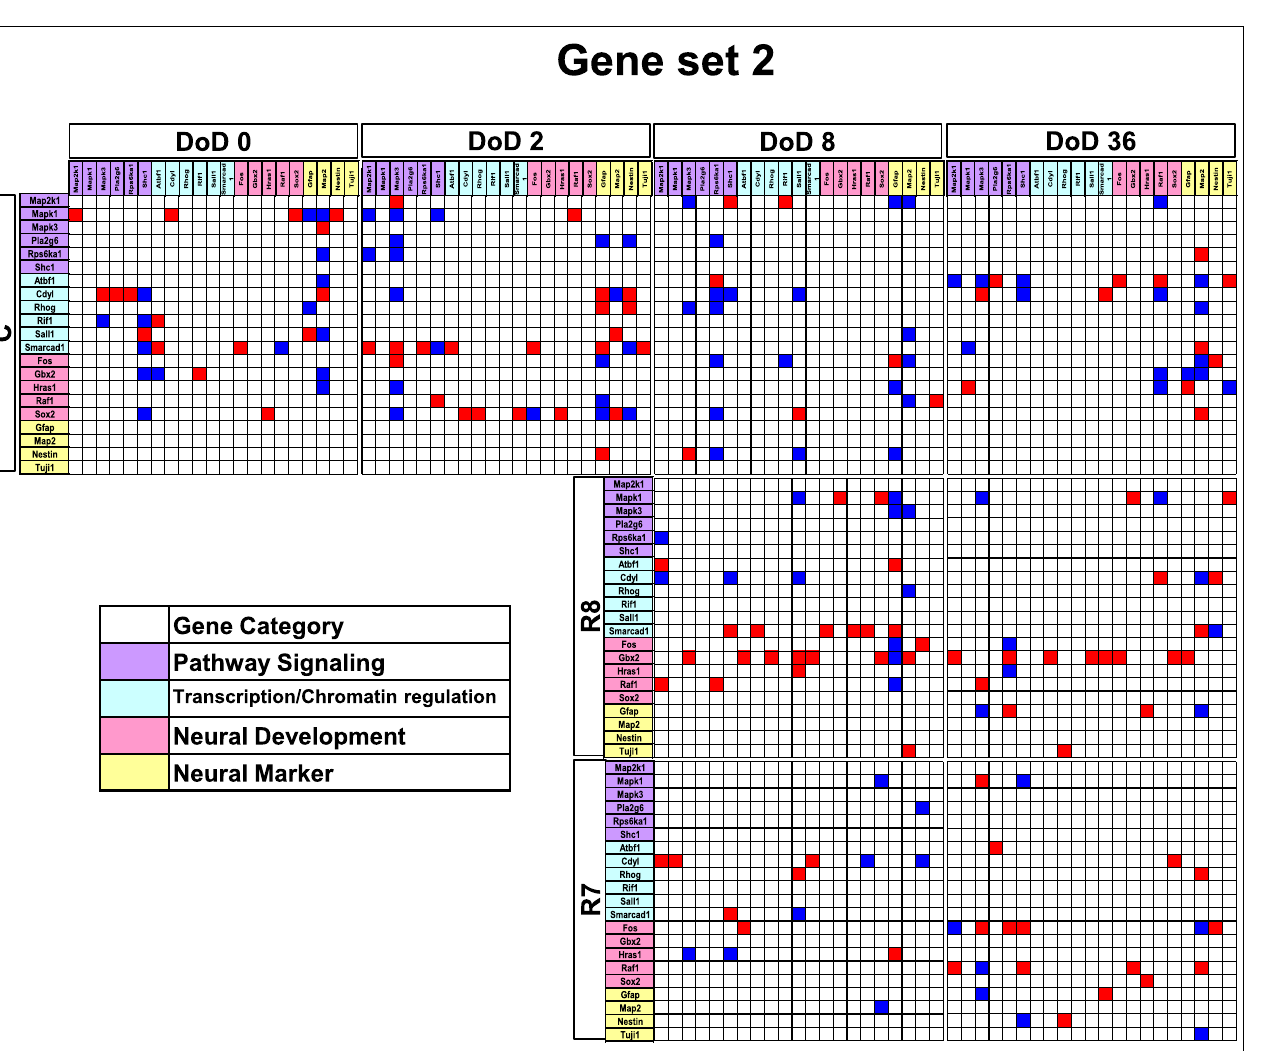
x axis. Red indicates upregulated genes and blue indicates down regulated genes. Red indicates that genes from the y axis up regulated genes from the x axis. Blue indicates that genes from the y axis downregulated genes from the x axis. Symbols of C, R8, and R7 indicate vehicle control, RA 10 − 8 M, and RA 10 − 7